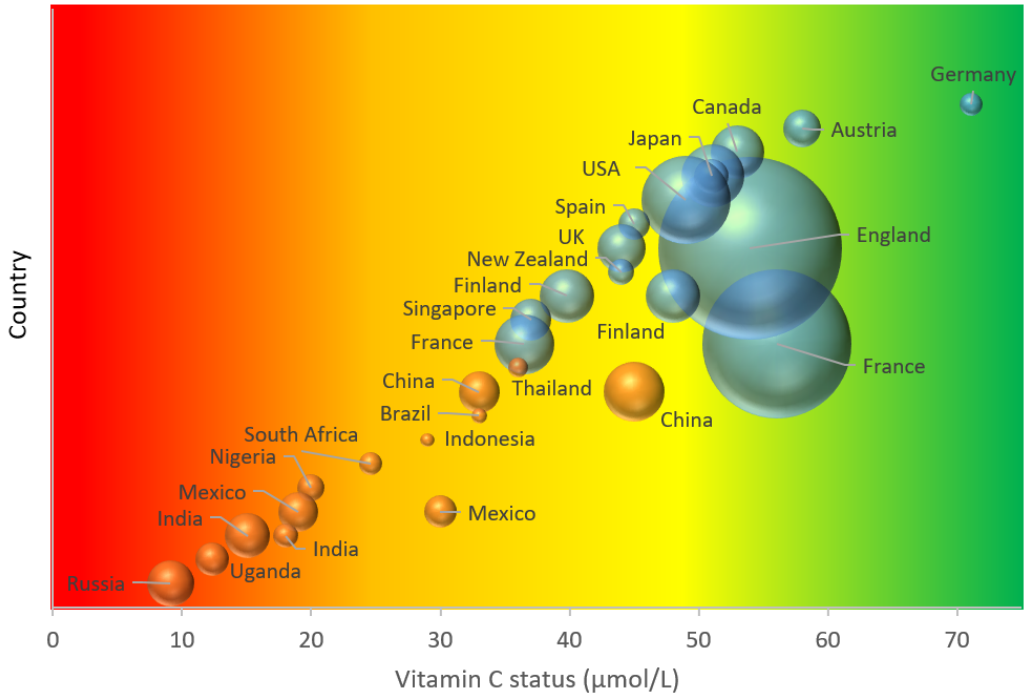
Figure 1. Global adult vitamin C status. The area of the bubble represents the size of the study. Blue bubbles represent high-income countries; orange bubbles represent low- and middle-income countries. Vitamin C status cutoffs: red — deficient (<11 µmol/L); orange — hypovitaminosis C (<23 µmol/L); yellow-inadequate (<50 µmol/L); green — adequate (>50 µmol/L).